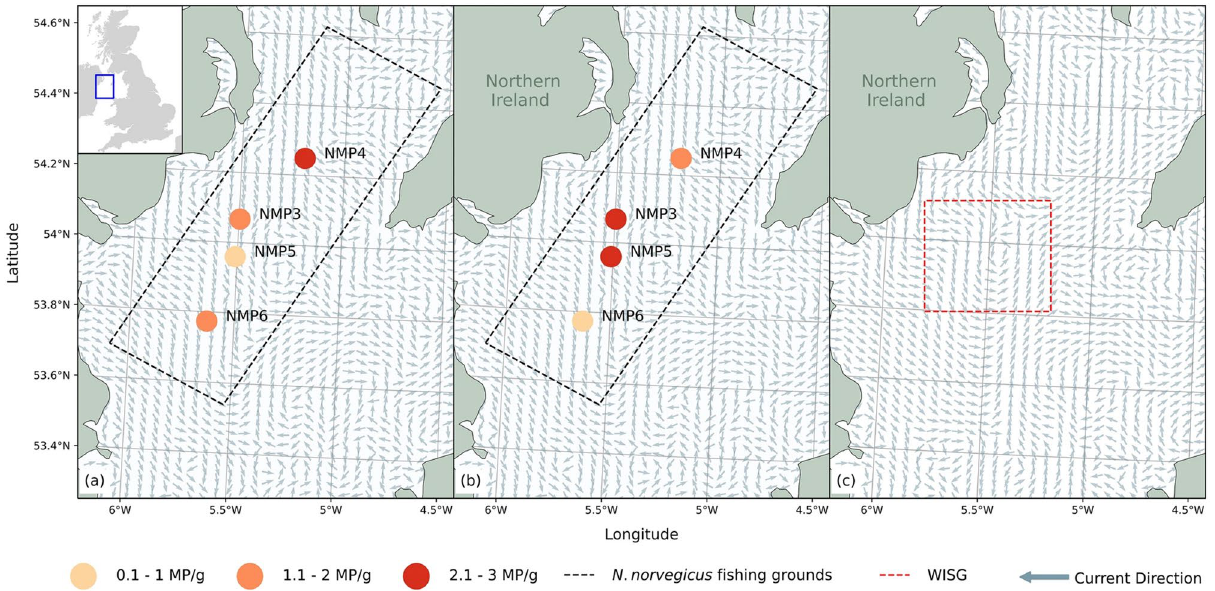
Figure 1. The location, site ID and mean microplastics per gram (MP/g) found within the four sediment sampling sites from the Western Irish Sea fishing grounds in ( a ) January 2016 and ( b ) January 2019. Monthly modelled residual currents for January 2020 ( a , b ) and July 2020 ( c ) demonstrating the development of the WISG in early summer. Modelled current data from E.U. Copernicus Marine Service Information 25